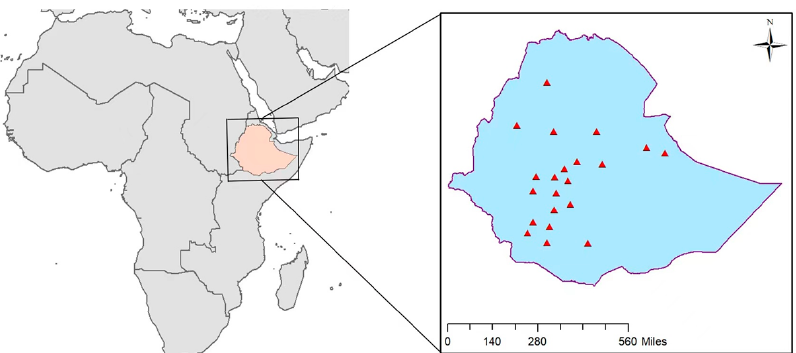
Figure 3. Distribution of meteorological stations in Ethiopia. Table 1. Geographical locations of 21 meteorological stations in Ethiopia.